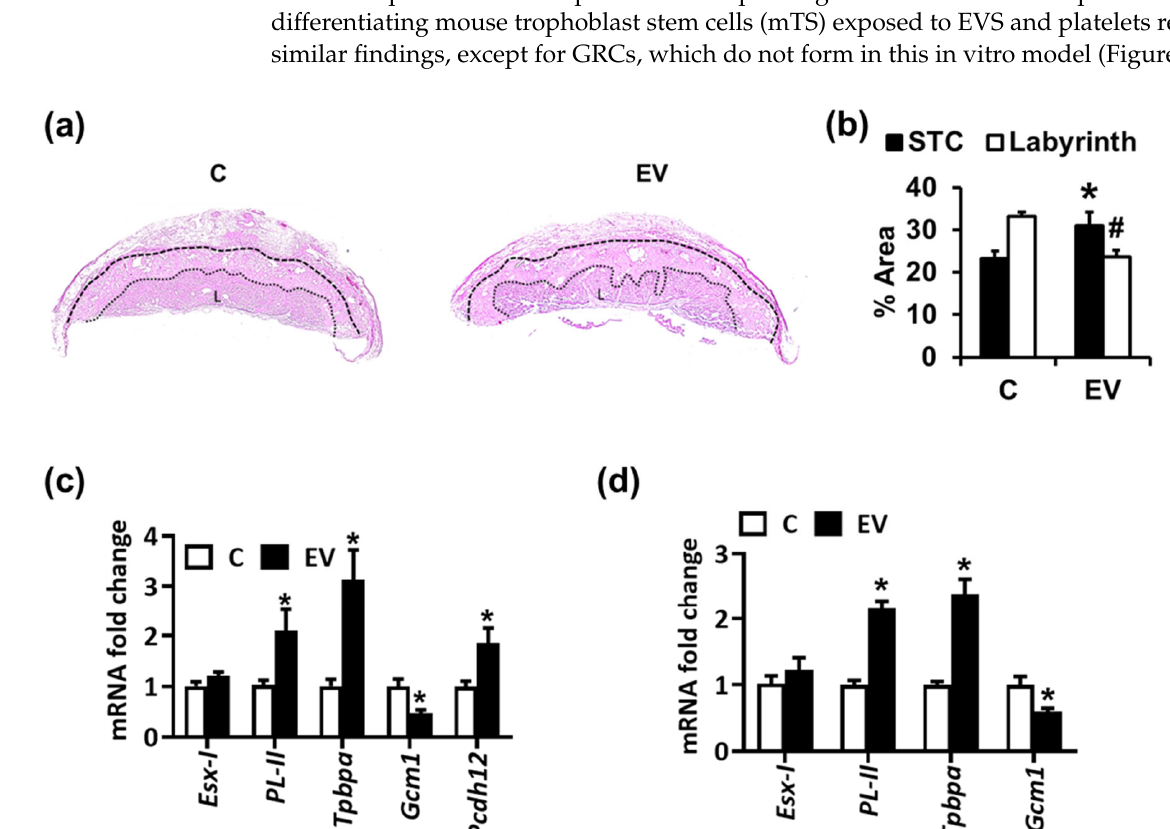
Figure 1. Extracellular vesicles (EVs) alter placental morphology and trophoblast differentiation. ( a , b ) Hematoxylin and eosin (H&E) stained placentae (( a ), representative images; ( b ), bar graph summarizing results) showing a reduced labyrinth zone (LZ) and increased junctional zone (JZ) in placenta from EV-injected mothers. * p < 0.05 (STC), # p < 0.05 (labyrinth); t -test. ( c , d ) qPCR analysis for markers of trophoblast differentiation and glycogen-rich cells in mouse placenta ( c ) or mouse trophoblast stem cells ( d ) showing an increase in spongiotrophoblast marker ( Tpbpa ), giant trophoblast marker ( PL-II ) and glycogen-rich cell marker ( Pcdh12 ), while the marker for syncytiotrophoblast differentiation Gcm-1 decreases upon EV treatment ( c , d ). * p < 0.05; t -test ( c , d ). n = 6 placentae from 3 different litters each group ( a – c ) or 3 independent repeat experiments ( d ).